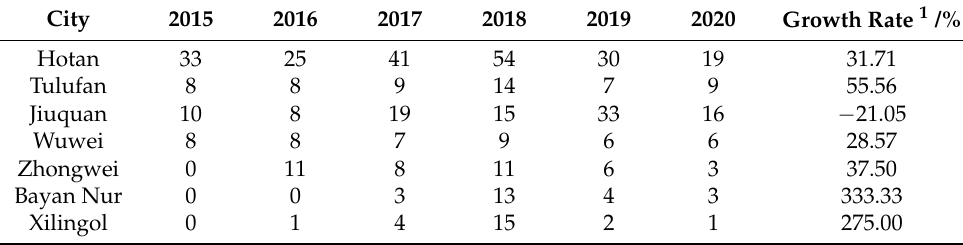
Figure 4. Annual dust frequencies of dust level III in the representative cities. Table 2. Annual dust frequencies of dust level III in the representative